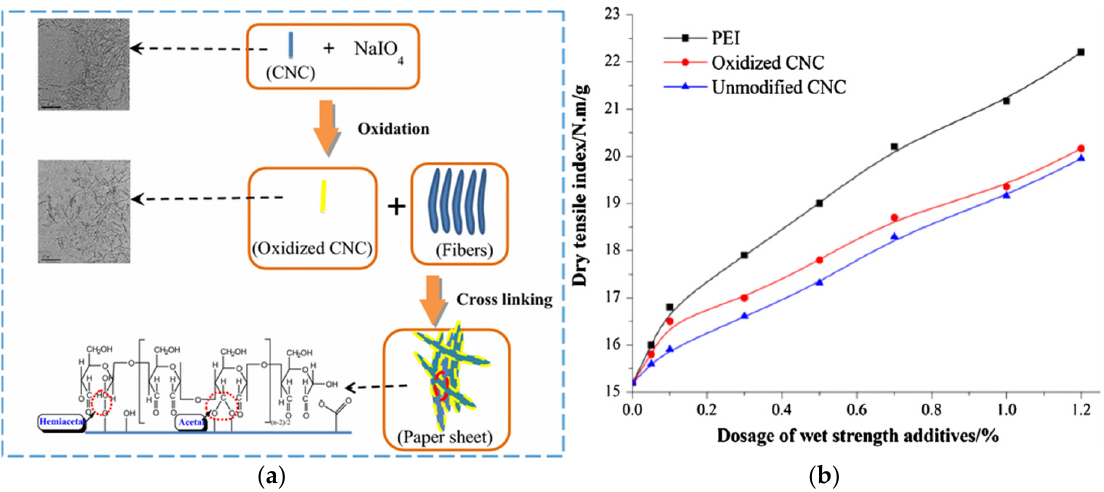
Figure 27. Interaction between oxidized nanocellulose and pulp fibrils ( a ), and tensile strength of composites made from unmodified nanocellulose-fibrils, modified nanocellulose-fibrils and PEI-fibrils ( b ) [89].